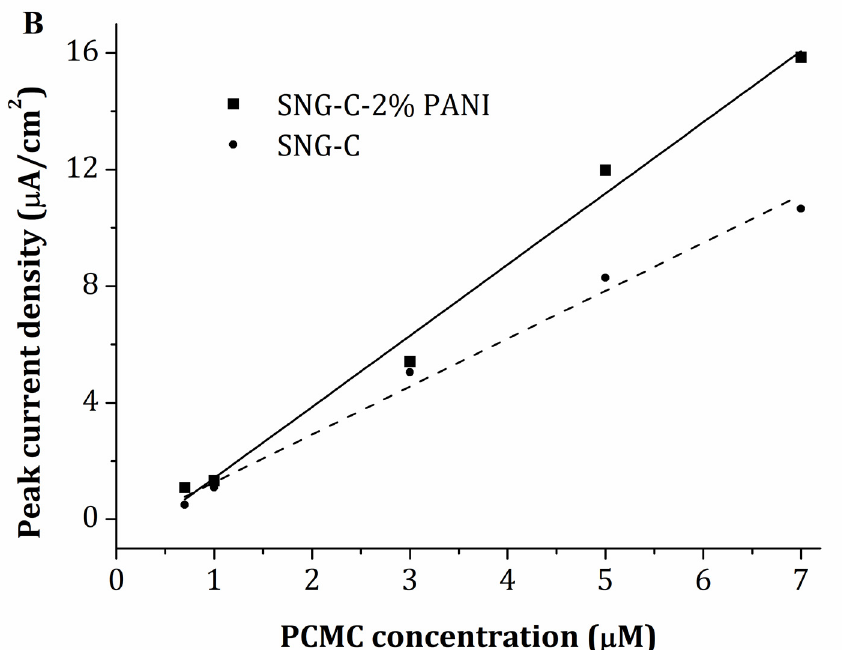
Figure 5. ( A ) Differential pulse voltammograms recorded with SNG–C–2% PANI in presence of different concentrations of PCMC. The inset reports the relevant calibration plots. ( B ) Calibration curve recorded with SNG–C–2% PANI and SNG–C in presence of different concentrations of 4-chloro-3-methylphenol in 0.1 M acetic/acetate with 0.5 M KCl at pH 4.